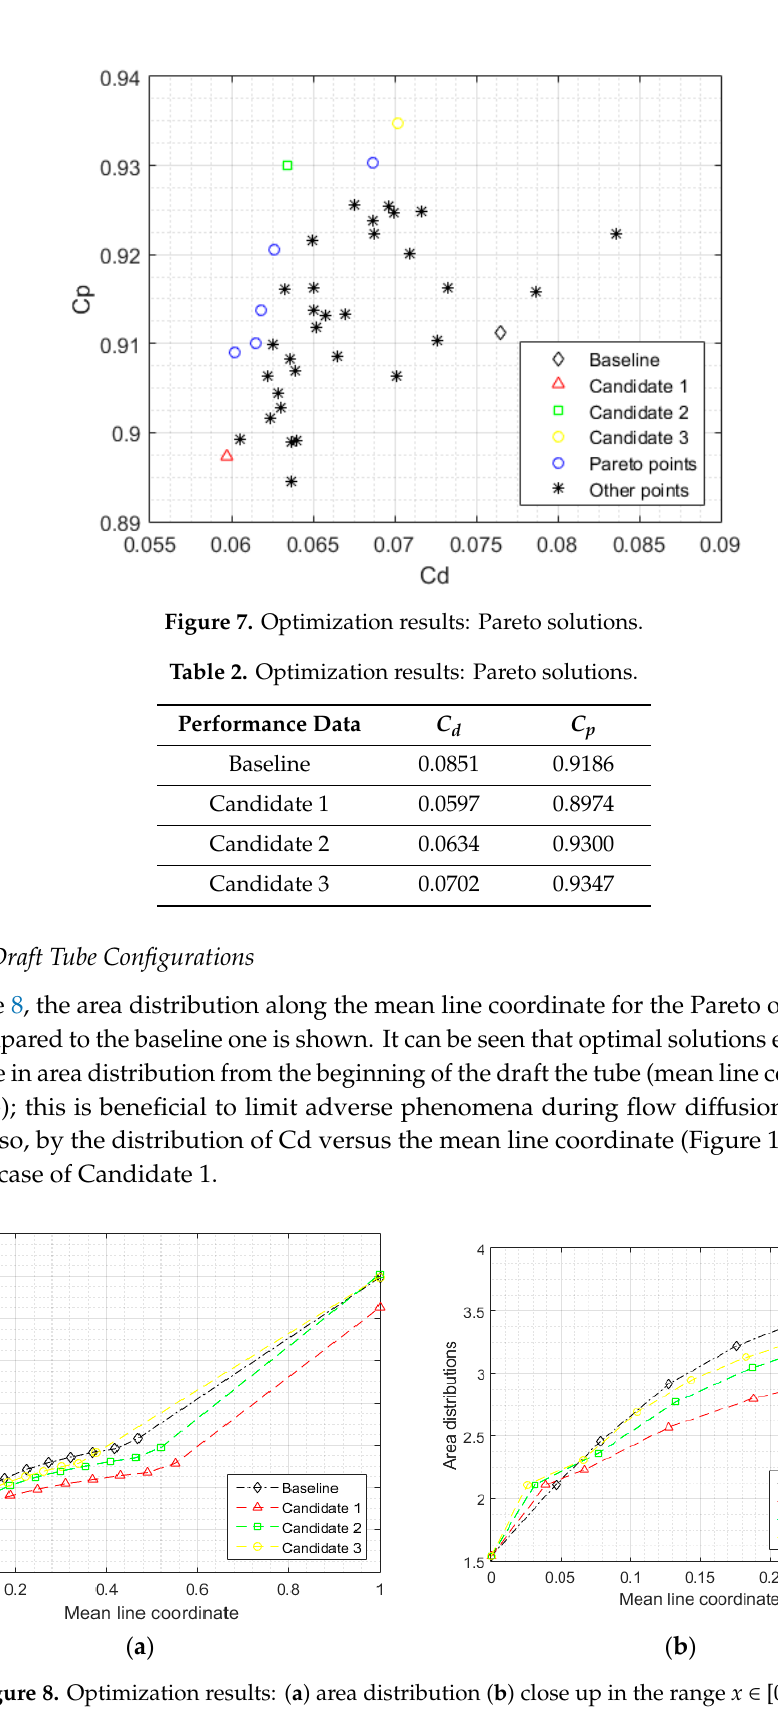
Figure 8. Optimization results: ( a ) area distribution ( b ) close up in the range x ∈ [0–0.3].